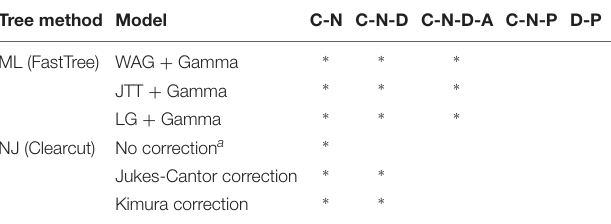
TABLE 1 | Support of lineage associations under different tree building methods. Tree method